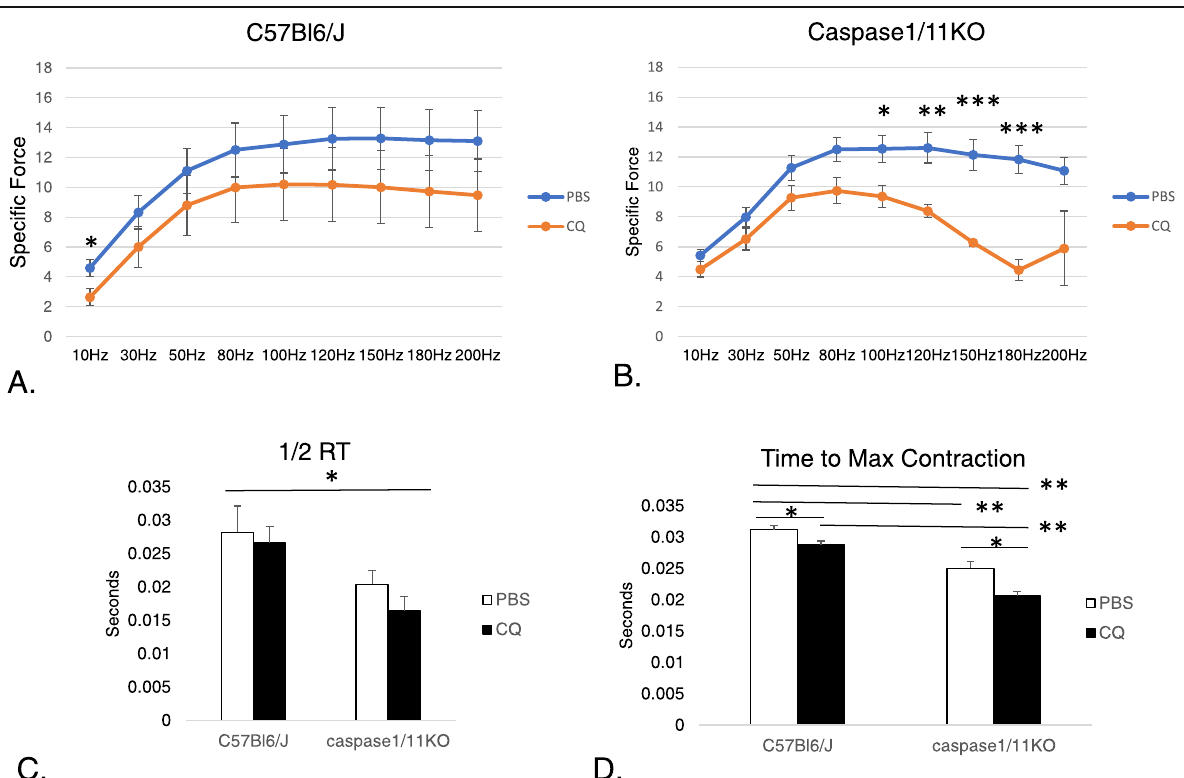
Fig. 7 Loss of caspase-1/11 in addition to CQ results in diminished tetanic peak force Peak force measurements in peroneal nerve after tetanic stimulation at indicated frequencies (Hz) for each mouse in ( a ) C57Bl/6 J (WT) mice treated with PBS or CQ;* p < 0.05: PBS:CQ at 10 Hz, N = 5 PBS and 5 CQ B; or ( b ) Caspase-1/11KO mice treated with PBS or CQ; p < 0.05 PBS:CQ 100 Hz, ** p < 0.01 PBS:CQ 120 Hz; *** p < 0.001 PBS:CQ 150 Hz and 180 Hz, N = 5 PBS and 5 CQ; ( c ) ½ relaxation time (RT) and ( d ) time to peak contraction in C57Bl/6/J and caspase-1/11KO after PBS or CQ treatment (C * p < 0.05; D * p = 0.003; ** p <